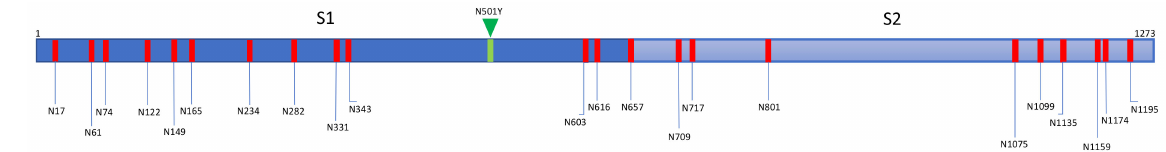
Figure 30. Localization of point mutation N501Y in the amino acid sequence of the S-glycoprotein from SARS-CoV-2. The actually glycosylated N -glycosylation sites distributed along the amino acid sequence are indicated by red rods and